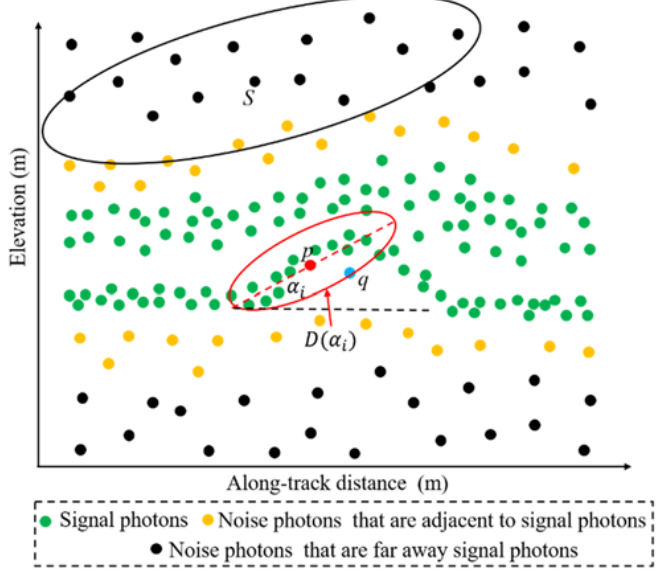
Figure 3. Schematic diagrams of the photon distribution and the forward elliptical distance.